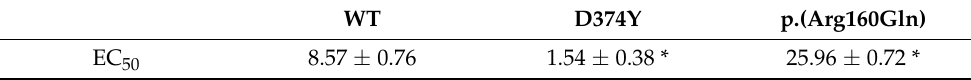
Table 3. EC 50 of the WT, D374Y GOF PCSK9 variant and the p.(Arg160Gln) PCSK9 variant.